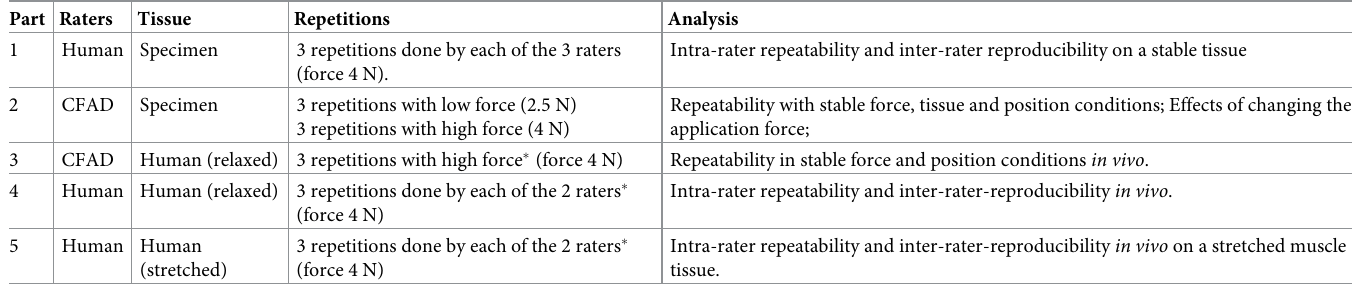
Table 1. Overview of steps undertaken in the